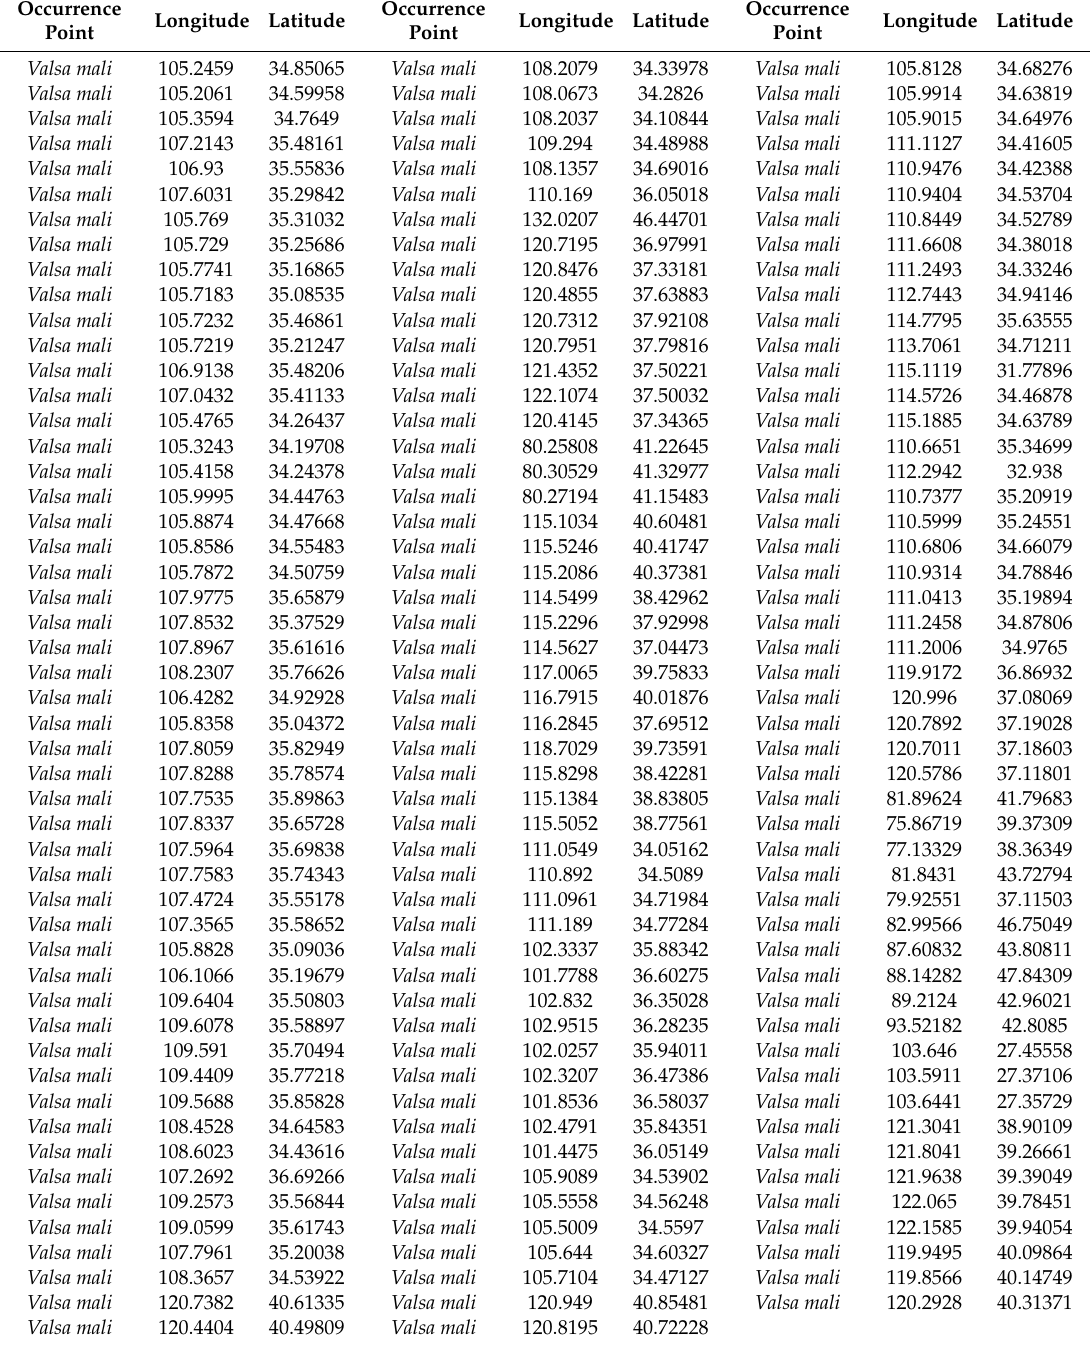
Table A1. The rarefying data points (158) of Valsa mali in